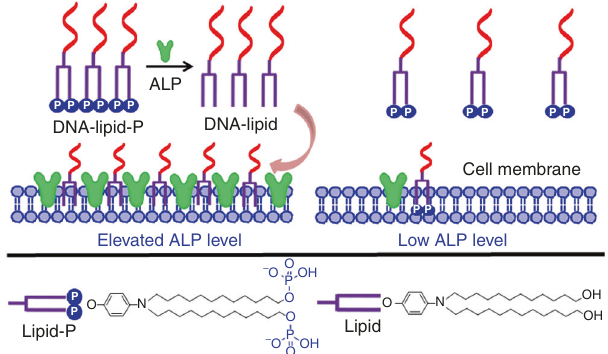
Fig. 1 Schematic of ALP-dependent cell membrane anchorage of